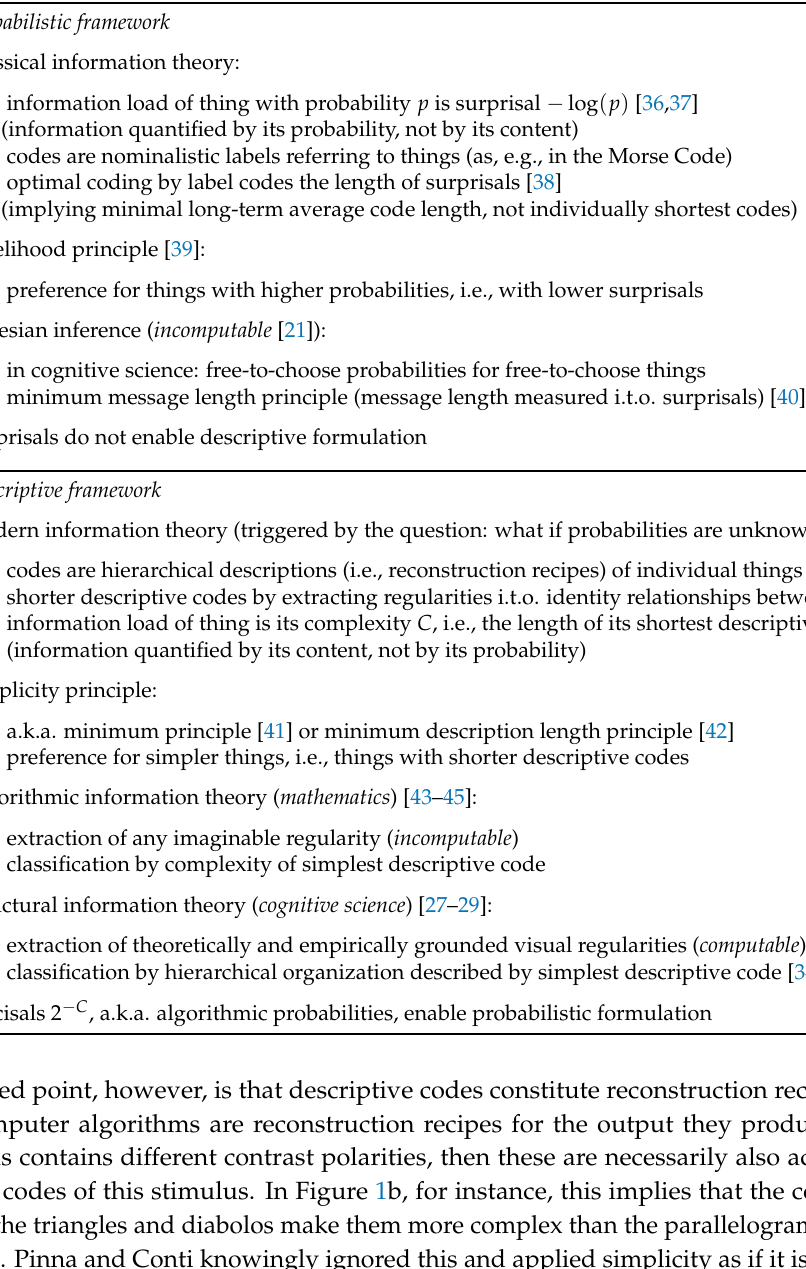
Table 1. Overview of probabilistic and descriptive